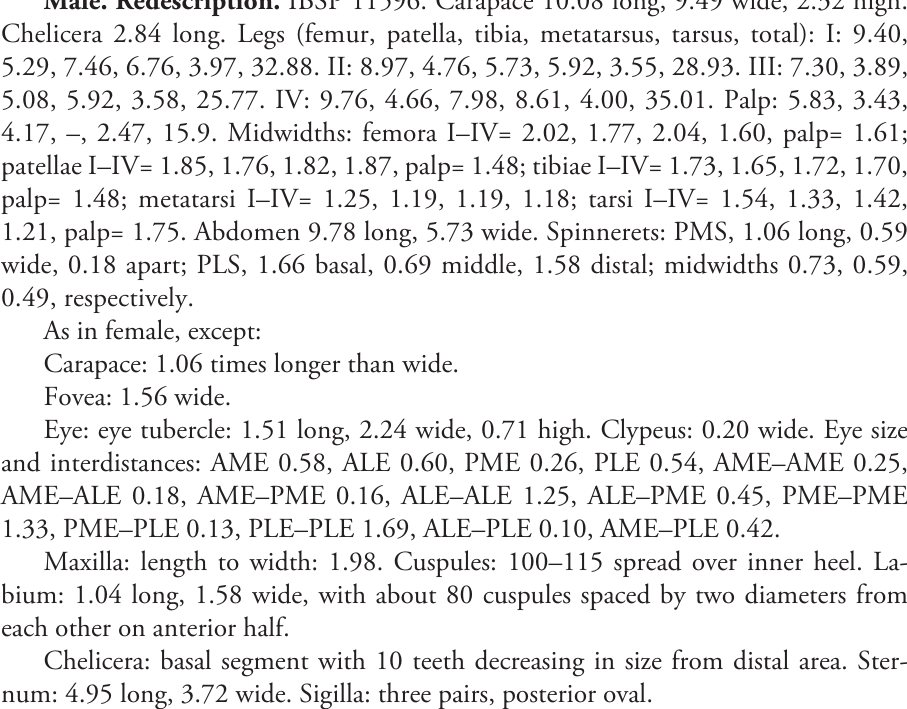
Maxilla: length to width: 1.98. Cuspules: 100–115 spread over inner heel. La- bium: 1.04 long, 1.58 wide, with about 80 cuspules spaced by two diameters from each other on anterior